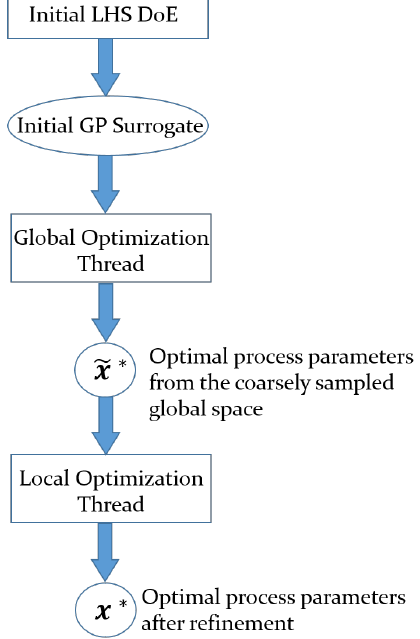
Figure 11. Flowchart depicting the global–local optimization